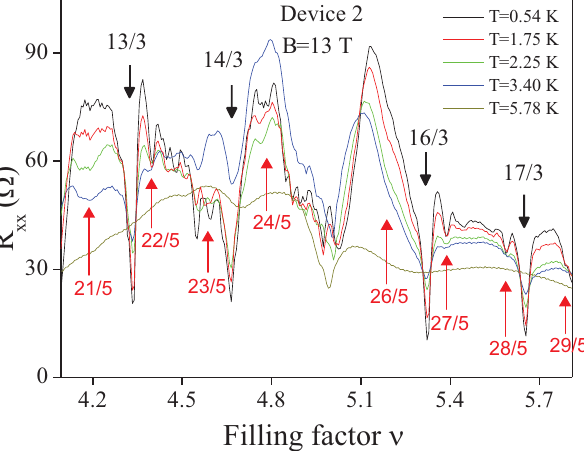
Figure 6. Resistivity R xx for the bilayer graphene experiment 5 for the first two subbands with n = 2 from the first LL ( ν ∈ (4, 6) ) (a third sample). The pronounced FQHE features for fractions with denominator 3 for single-loop commensurability (due to leakage of flux between the two sheets of the bilayer structure) and for fractions with denominator 5, also for single-loop braid commensurability, are marked. [adapted from ref. 5 under CC-BY 4.0, coloured fractions are added].